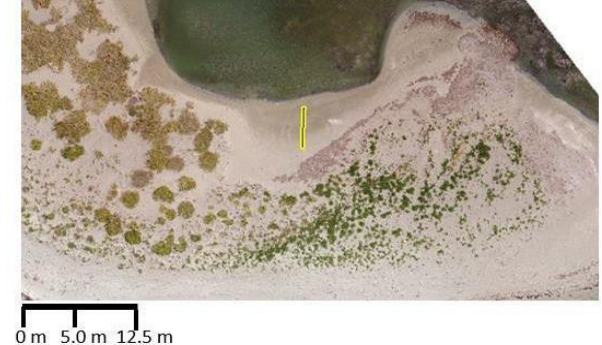
Figure 2. Location of the cross for the profile comparison without vegetation.